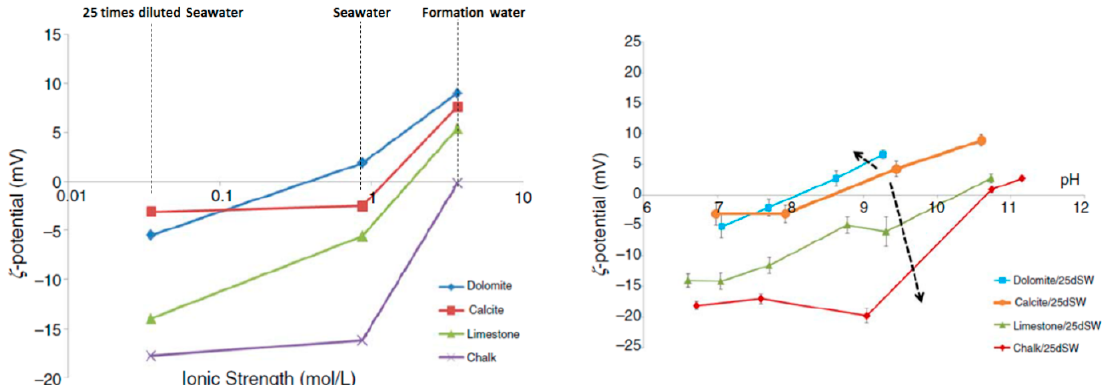
Figure 5. Comparison between ζ -potential of chalk, calcite, limestone and dolomite in different brine salinity (plotted in log-scale) at reservoir pH of 7 ( left ) and in 25 times diluted seawater at pH range 6–11 ( right ) (reproduced from Mahani et al. [99] with permission).